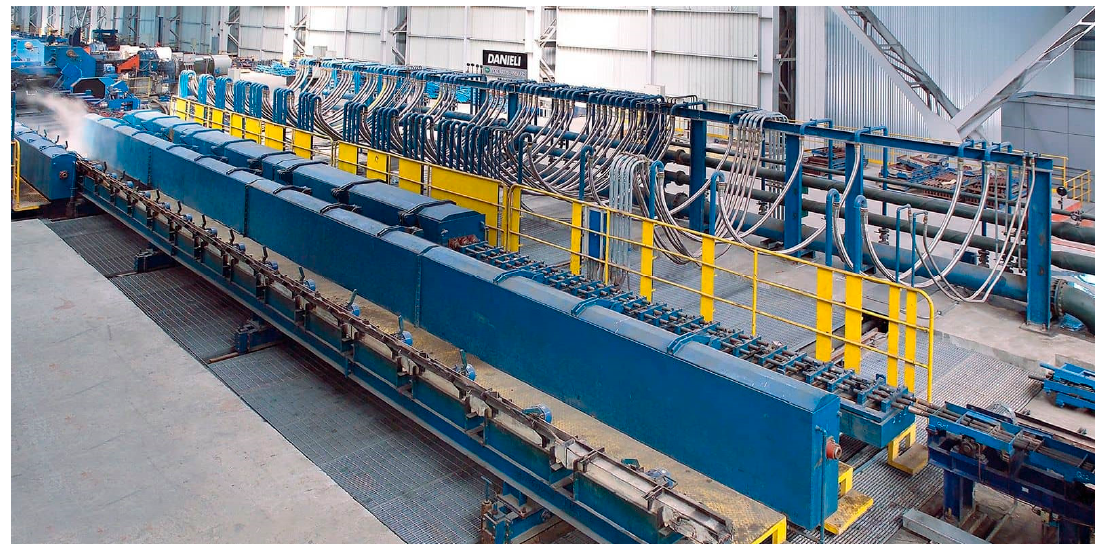
Figure 3. Industrial Tempcore production line.